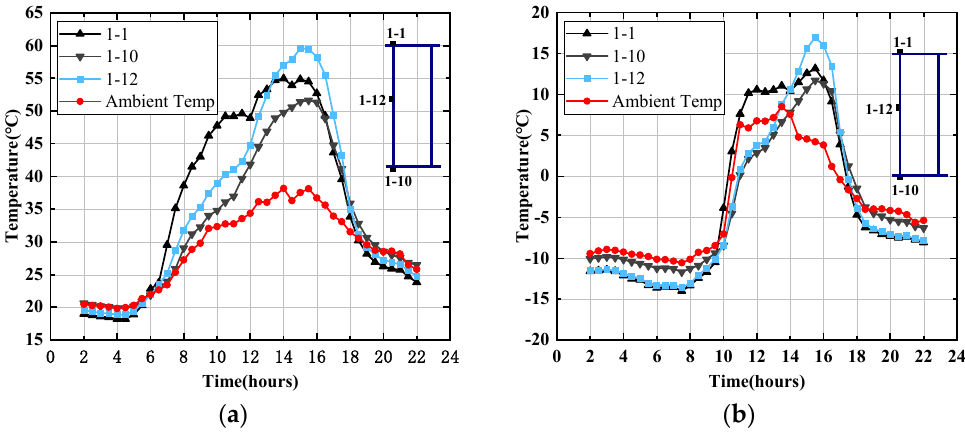
Figure 4. Diurnal variation curves of temperature at different heights. ( a ) summer; ( b ) winter.